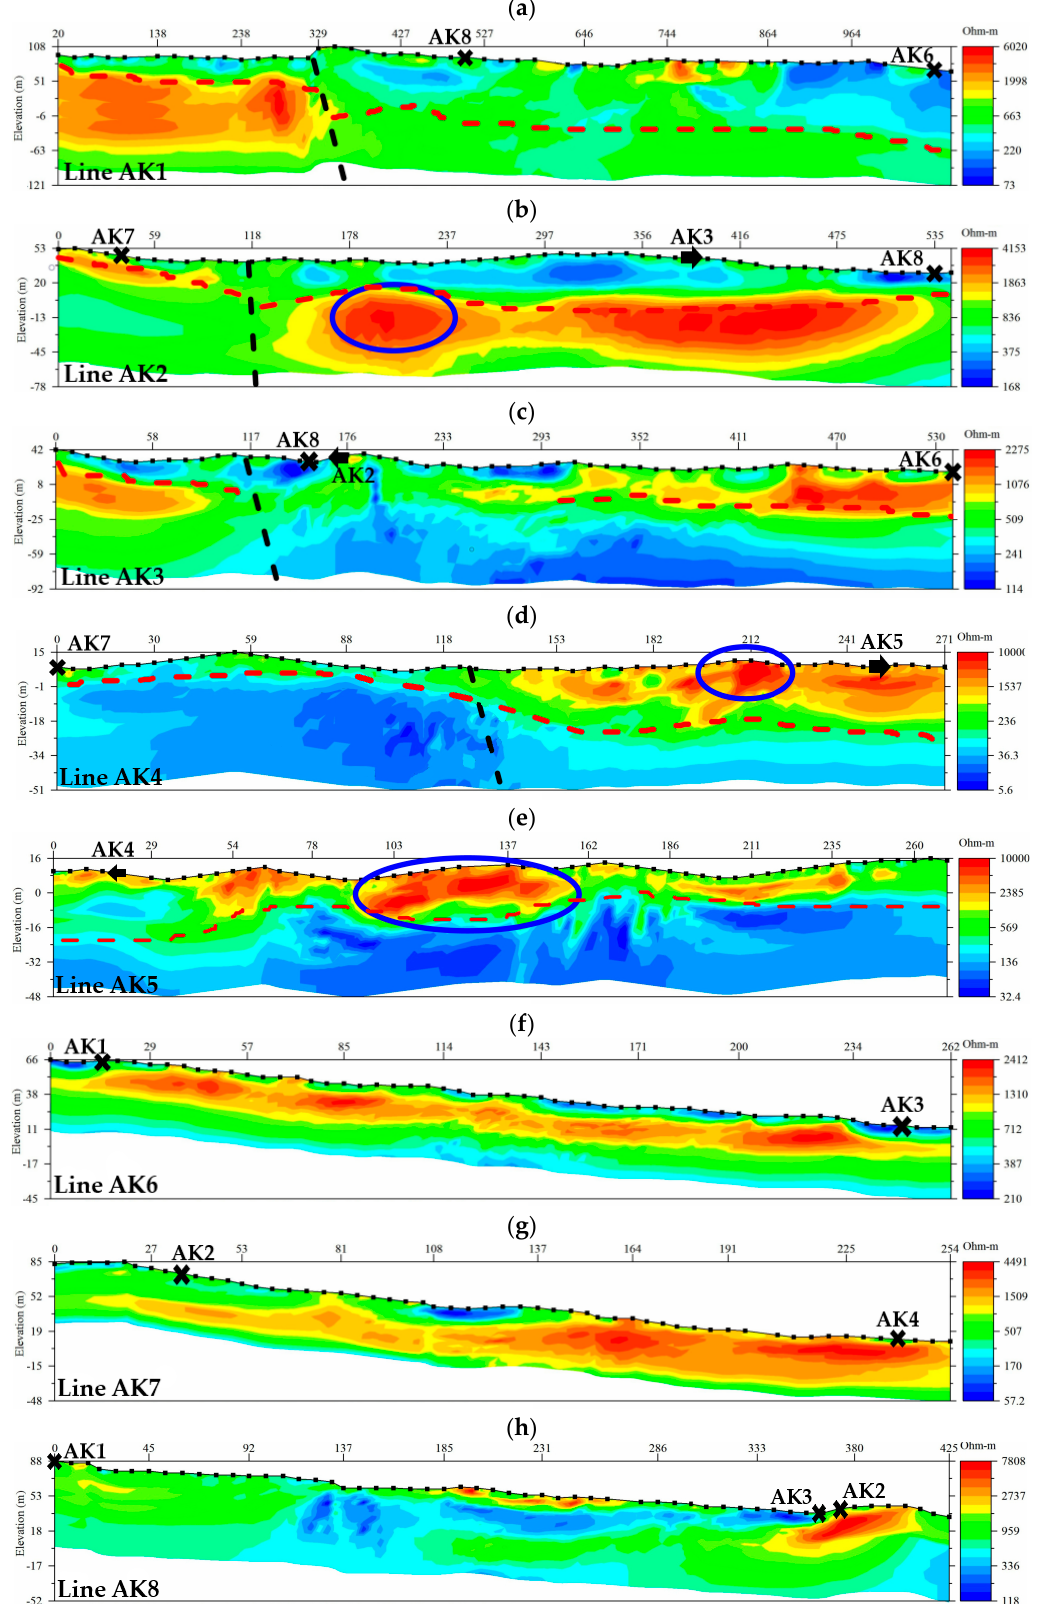
Figure 7. 2D ERT sections of the survey lines. Blue circles for higher resistivity areas corresponding to the location of the spring L2. The red dashes in the sections are representing the groundwater hydraulic head along with the profile. These data were reconstructed by the interpolation of the measured hydraulic